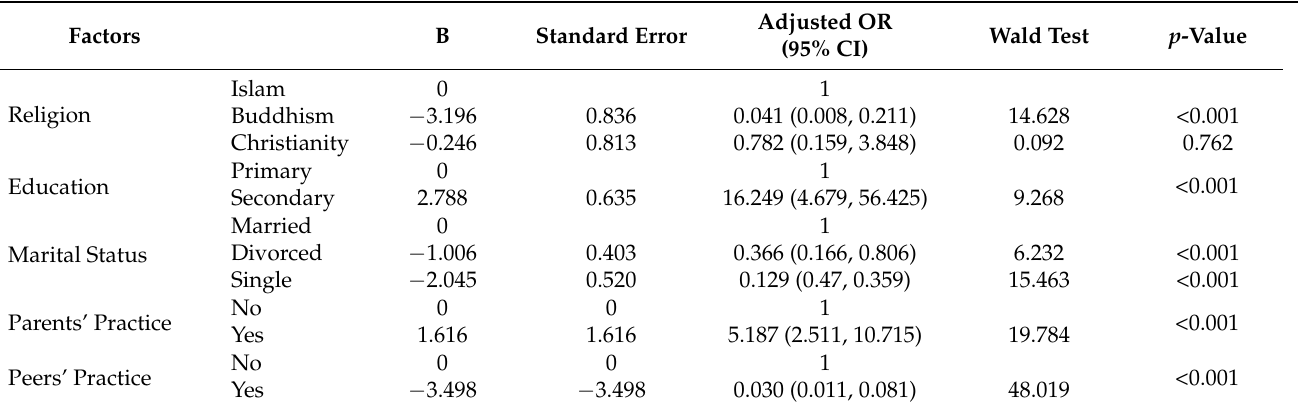
Table 4. Associated factors of smoking among women inmates in Kelantan (Multiple Logistic Regression) (n =